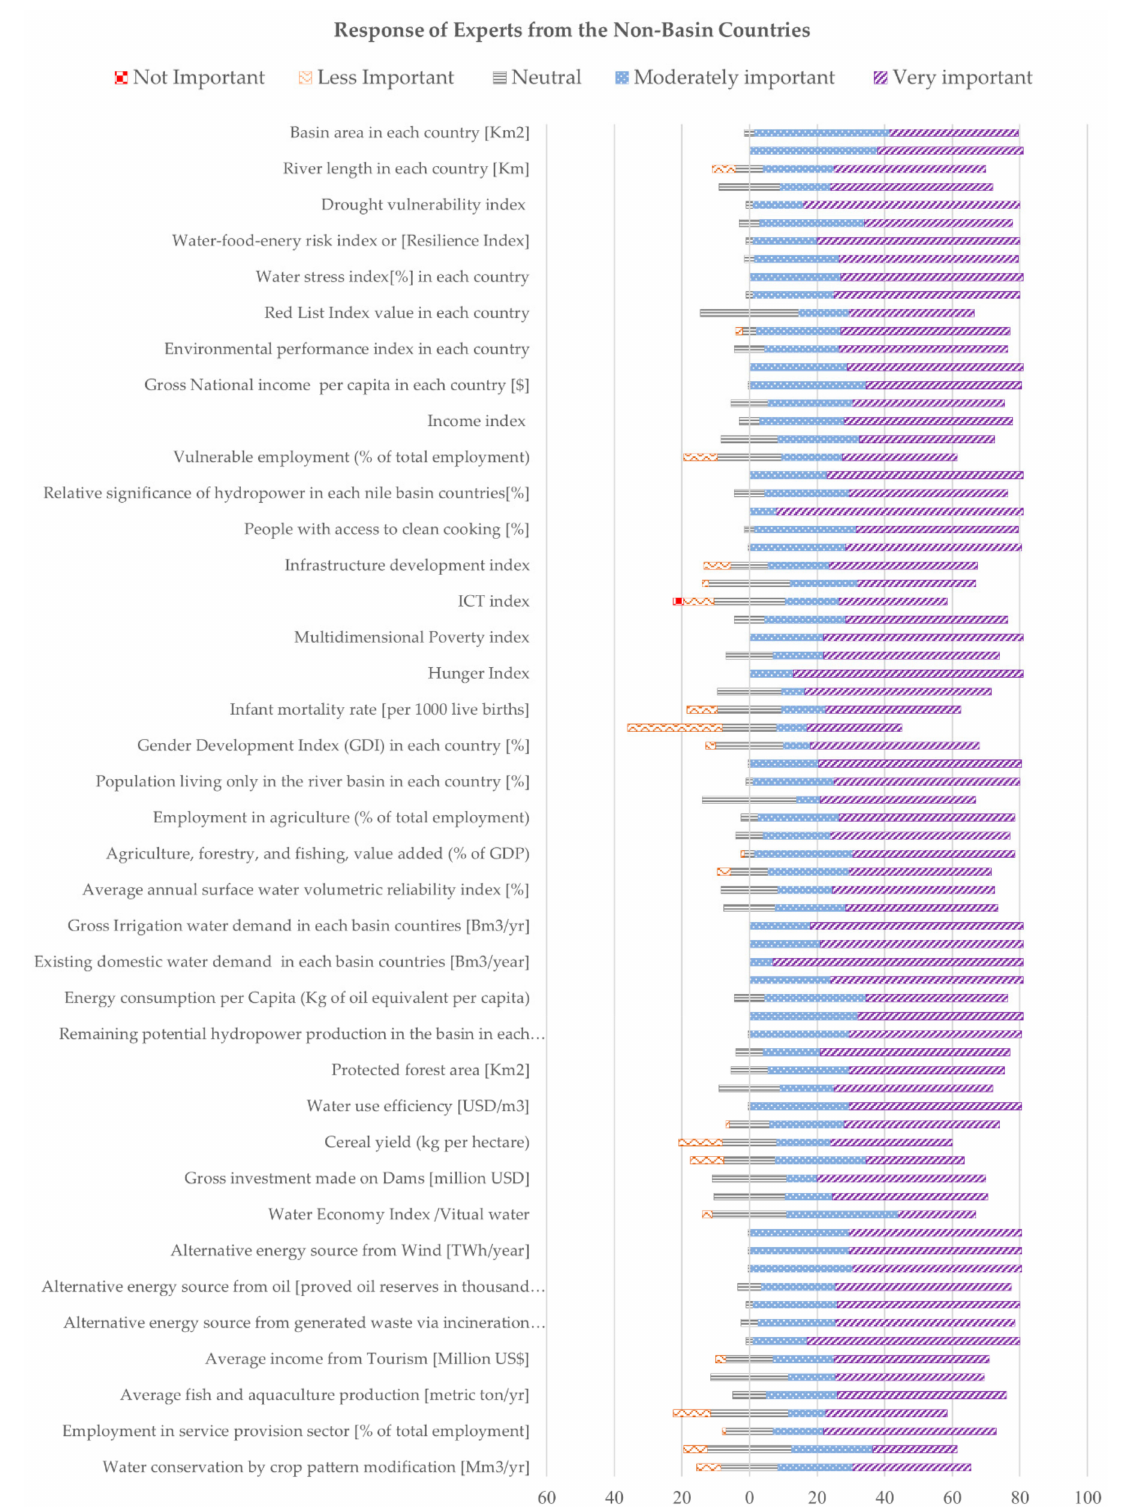
Figure 6. A percentage summary of survey responses for indicators from non-basin state